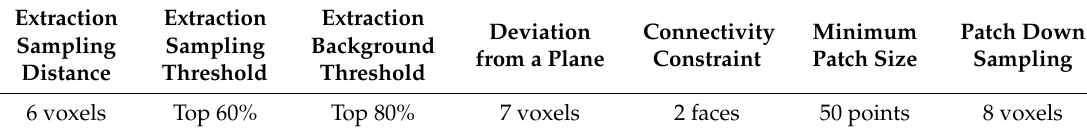
Table 3. Parameters used in the extraction of the fault patches in this study.